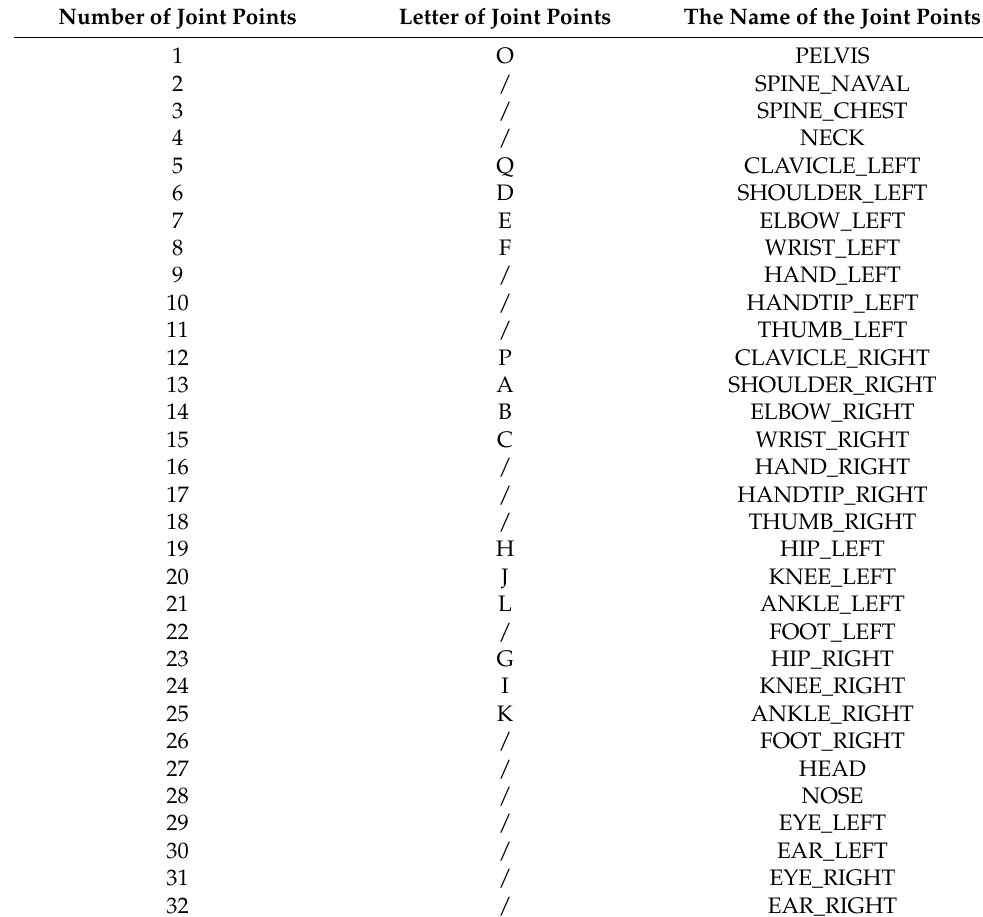
Table 2. Kinect gets 32 joint